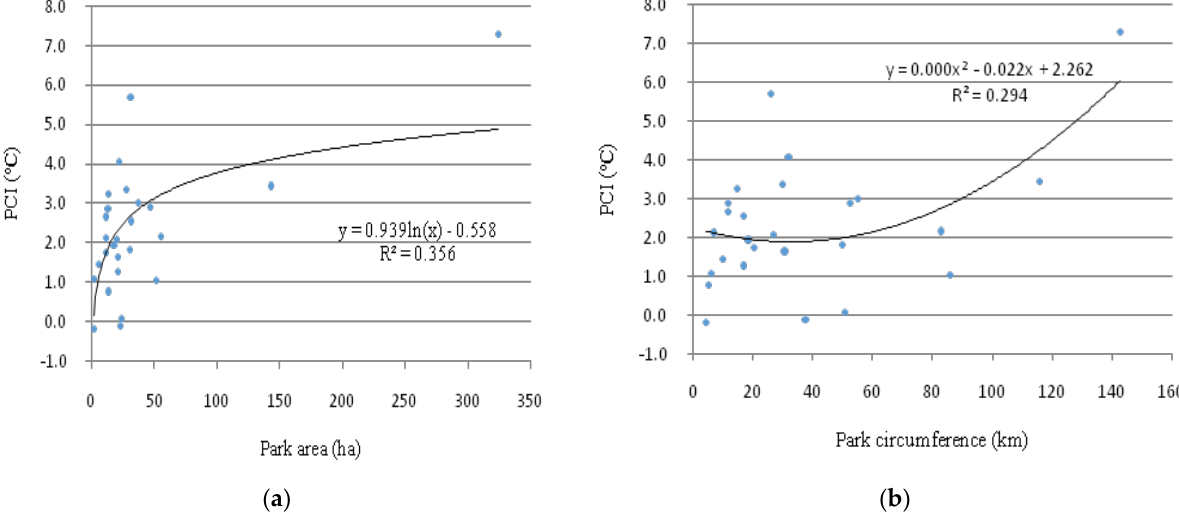
Figure 3. Scatterplots and fitting curves between the PCI intensity and ( a ) park area at the significance level of 0.01 and ( b ) park circumference at the significance level of 0.05 ( n =27).